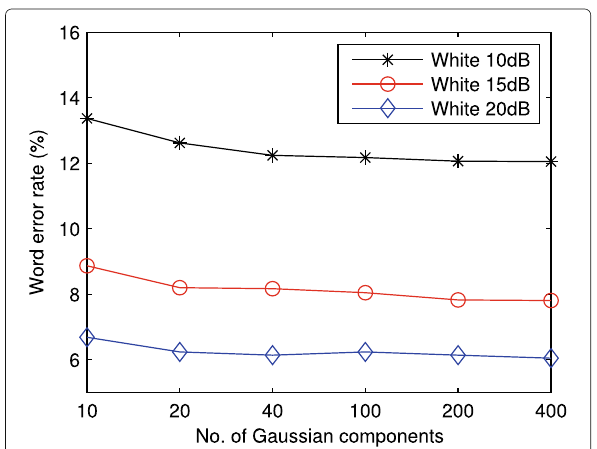
Fig. 3 Word error rates of the proposed algorithm with different numbers of Gaussian components